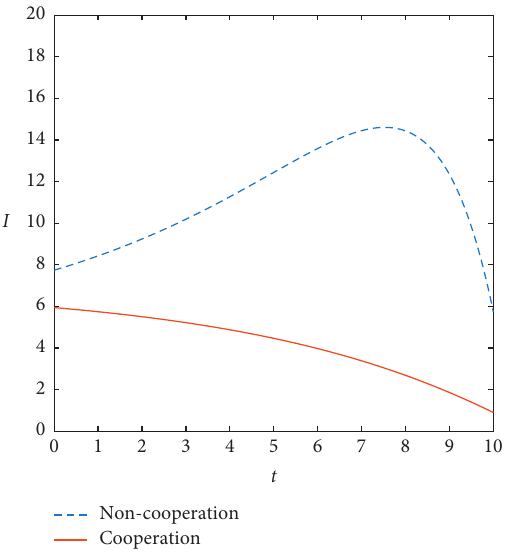
Figure 9: Optimal trajectory of pollution abatement investment under cooperation and non-cooperation when the planning period T � 10.